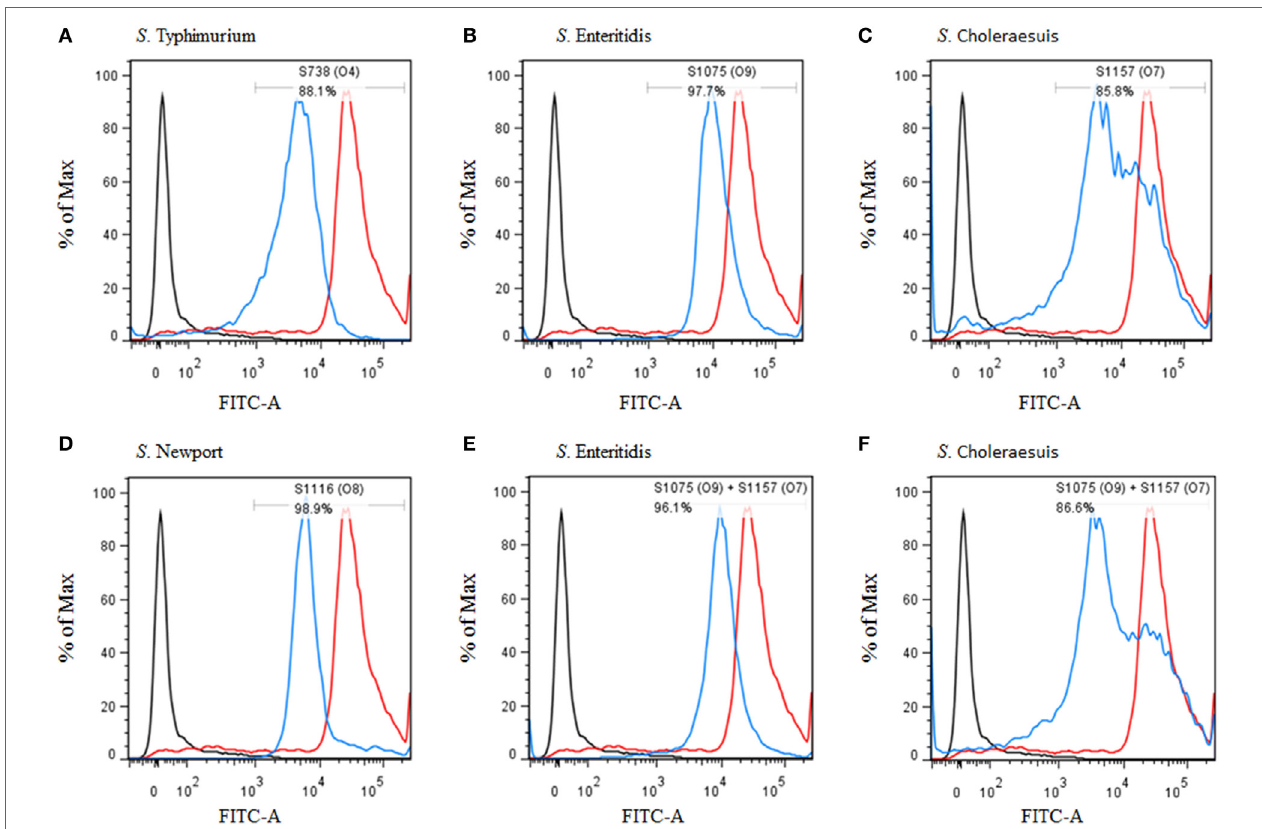
FigUre 4 | Flow cytometry histograms of C3 complement deposition. The percentage of FITC-positive bacteria was determined by flow cytometry. (a) Wild-type S. Typhimurium was incubated with sera from mice vaccinated with S738 (O4). Approximately 88.1% of bacteria were positive. (B) Wild-type S . Enteritidis was incubated with sera from mice vaccinated with S1075 (O9). Approximately 97.7% of bacteria were positive. (c) Wild-type S . Choleraesuis was incubated with sera from mice vaccinated with S1157 (O7). Approximately 85.8% of bacteria were positive. (D) Wild-type S . Newport was incubated with sera from mice vaccinated with S1116 (O8). Approximately 98.9% of bacteria were positive. (e) Wild-type S . Enteritidis was incubated with sera from mice co-vaccinated with S1075 (O9) and S1157 (O7). Approximately 96.1% of bacteria were positive. (F) Wild-type S . Choleraesuis was incubated with sera from mice co-vaccinated with S1075(O9) and S1157 (O7). Approximately 86.6% of bacteria were positive. The negative control (dark line) was wild-type S . Typhimurium incubated with sera from non-vaccinated mice, and the positive control (red line) was wild-type S . Typhimurium incubated with O4 single-factor rabbit